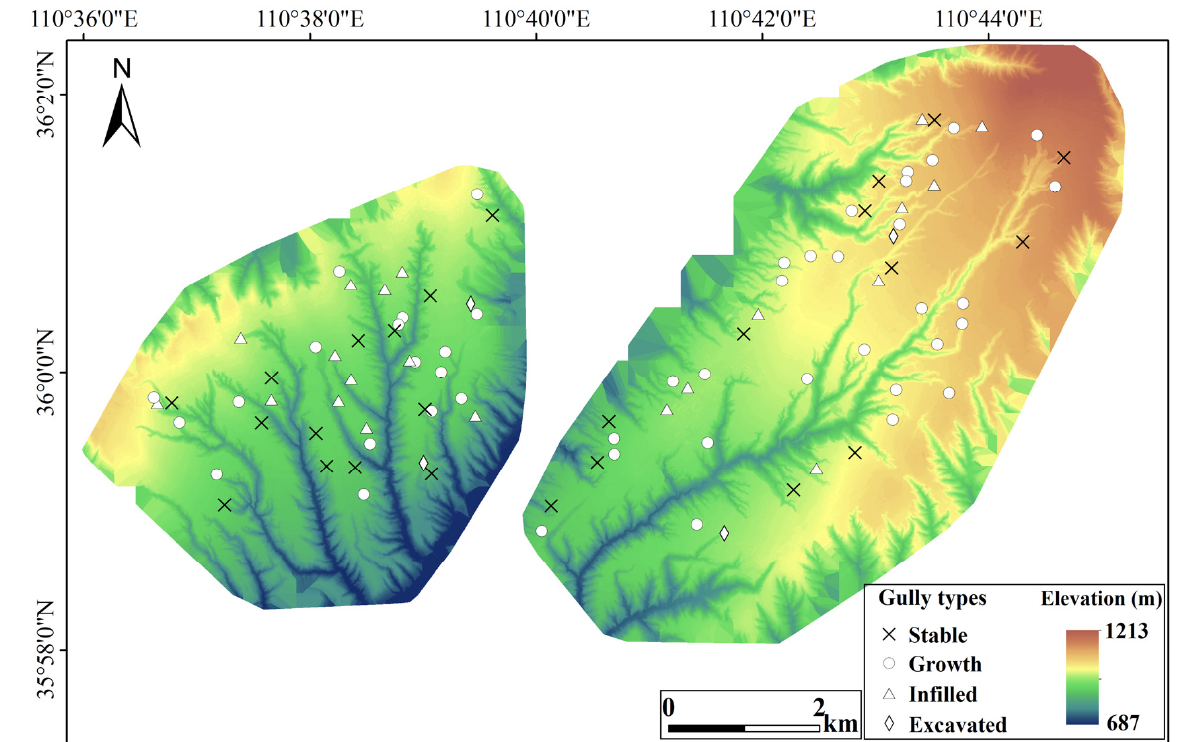
Figure 4. Distribution of the 4 types of gullies on the Zhongduo and Shiquan tablelands. The background images are the digital elevation models (DEMs) derived from the 2019 UAV images.